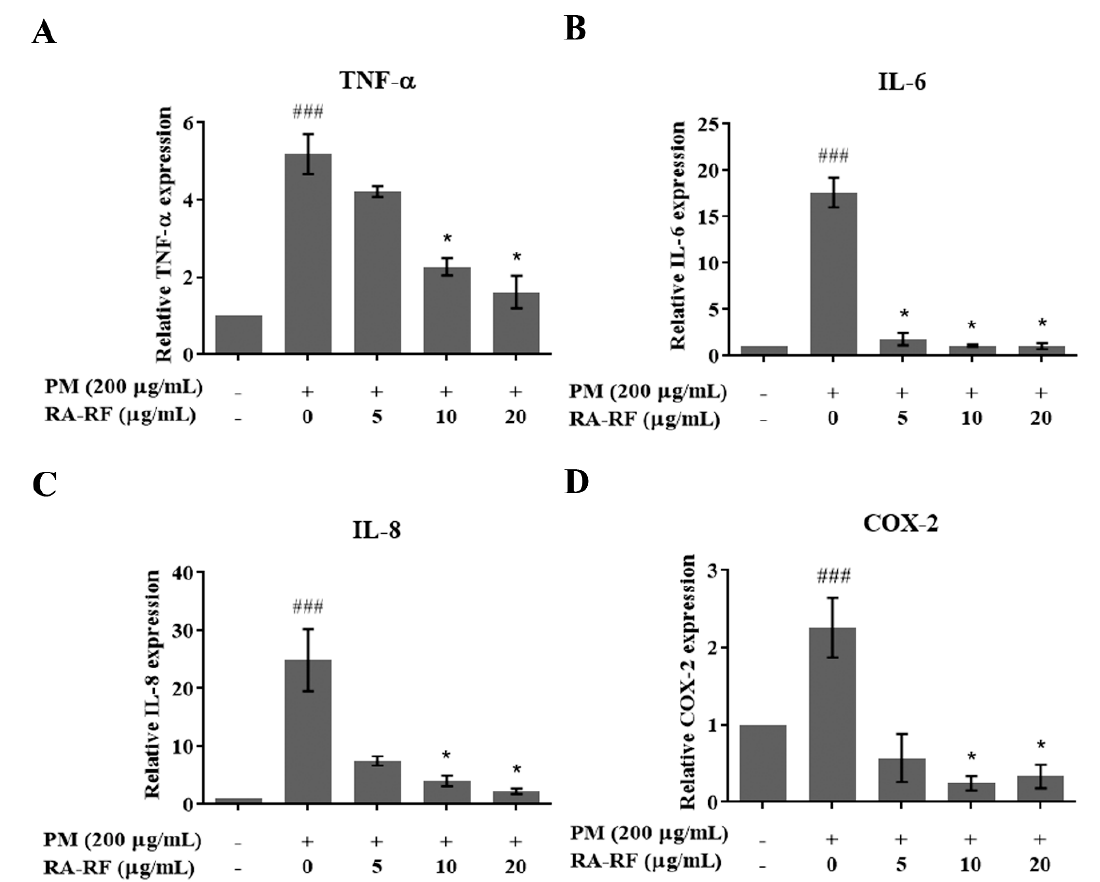
Figure 3. The gene expression profiles of inflammatory cytokines including TNF- α ( A ), IL-6 ( B ), IL-8 ( C ), and COX-2 ( D ) in A549 cells treated with PMFF (200 µ g/mL) in the presence of RA-RF (5–20 µ g/mL). The mean ± SEM are shown as ### p < 0.001 vs. the control group; * p < 0.05 vs. PMFF group. The data were independently performed in triplicate.